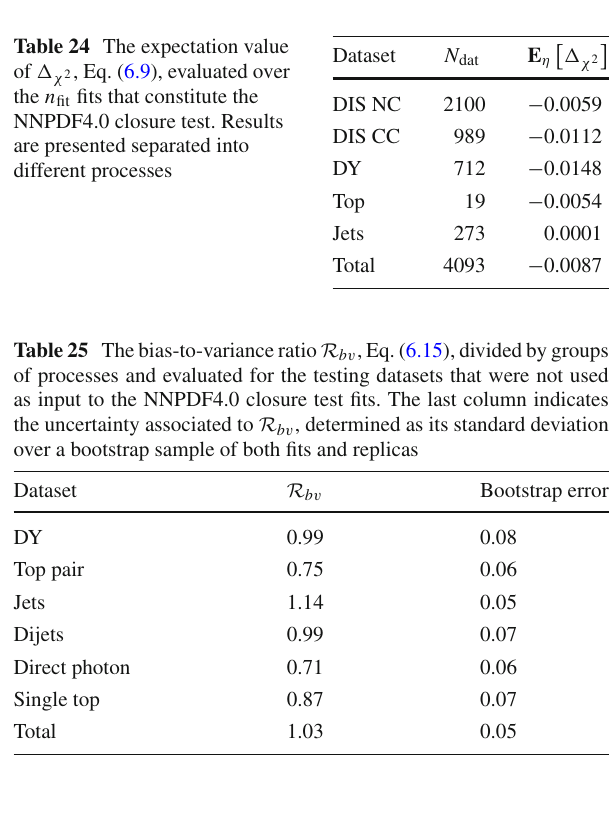
Fig. 24 The replica (solid green line) chosen as the true underlying PDF f for the closure test: the gluon (left) and quark singlet (right) are displayed. The NNPDF4.0 central value and 68% confidence interval (same as in Fig. 17) are also shown for reference